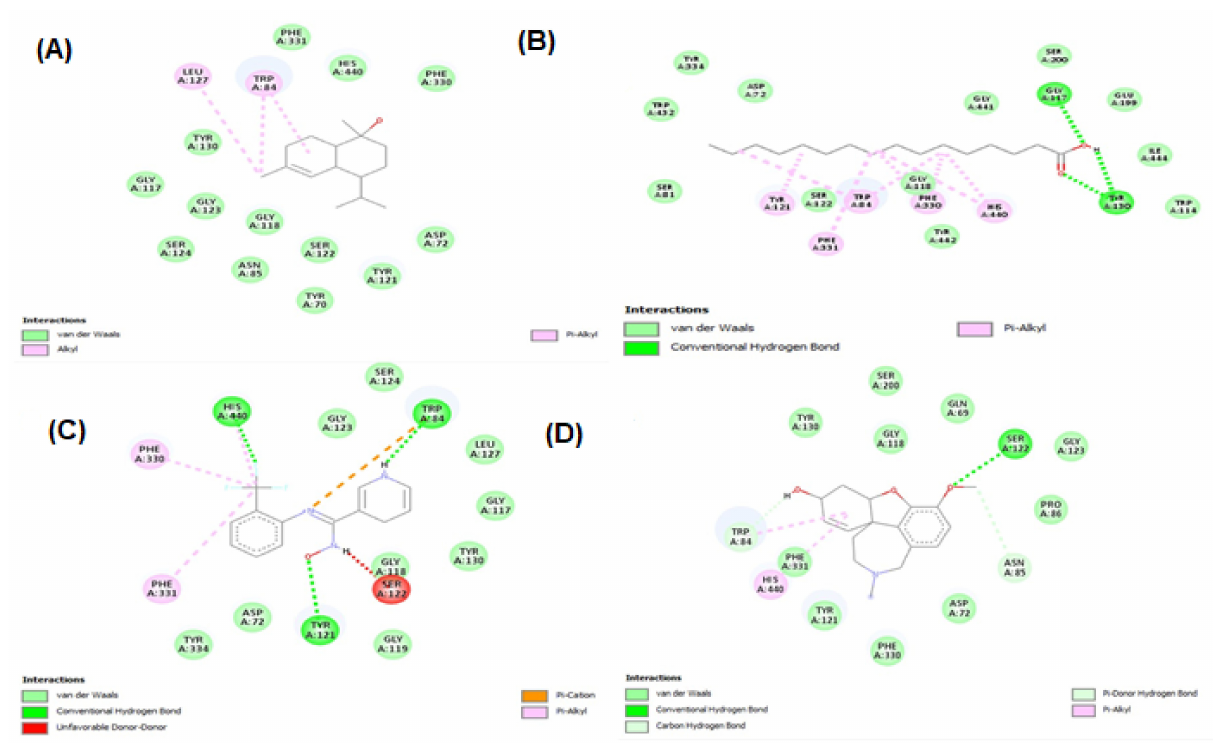
Figure 9. Interaction between acetylcholinesterase and ligands. ( A ) alpha–cadinol; ( B ) n-hexadecanoic acid; ( C ) N-hydroxy-N (cid:48) -[2-(trifluoromethyl)phenyl]pyridine-3-carboximidamide; and ( D ) galantamine.